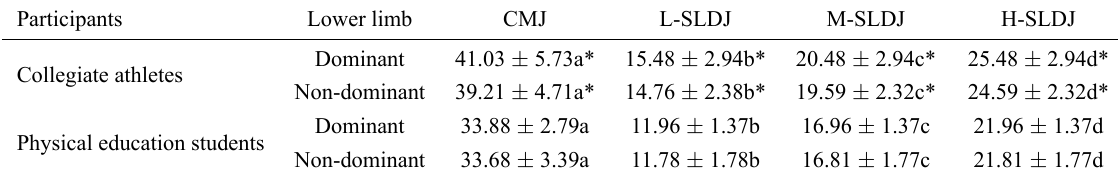
Table 1. CMJ and drop heights of dominant and non-dominant